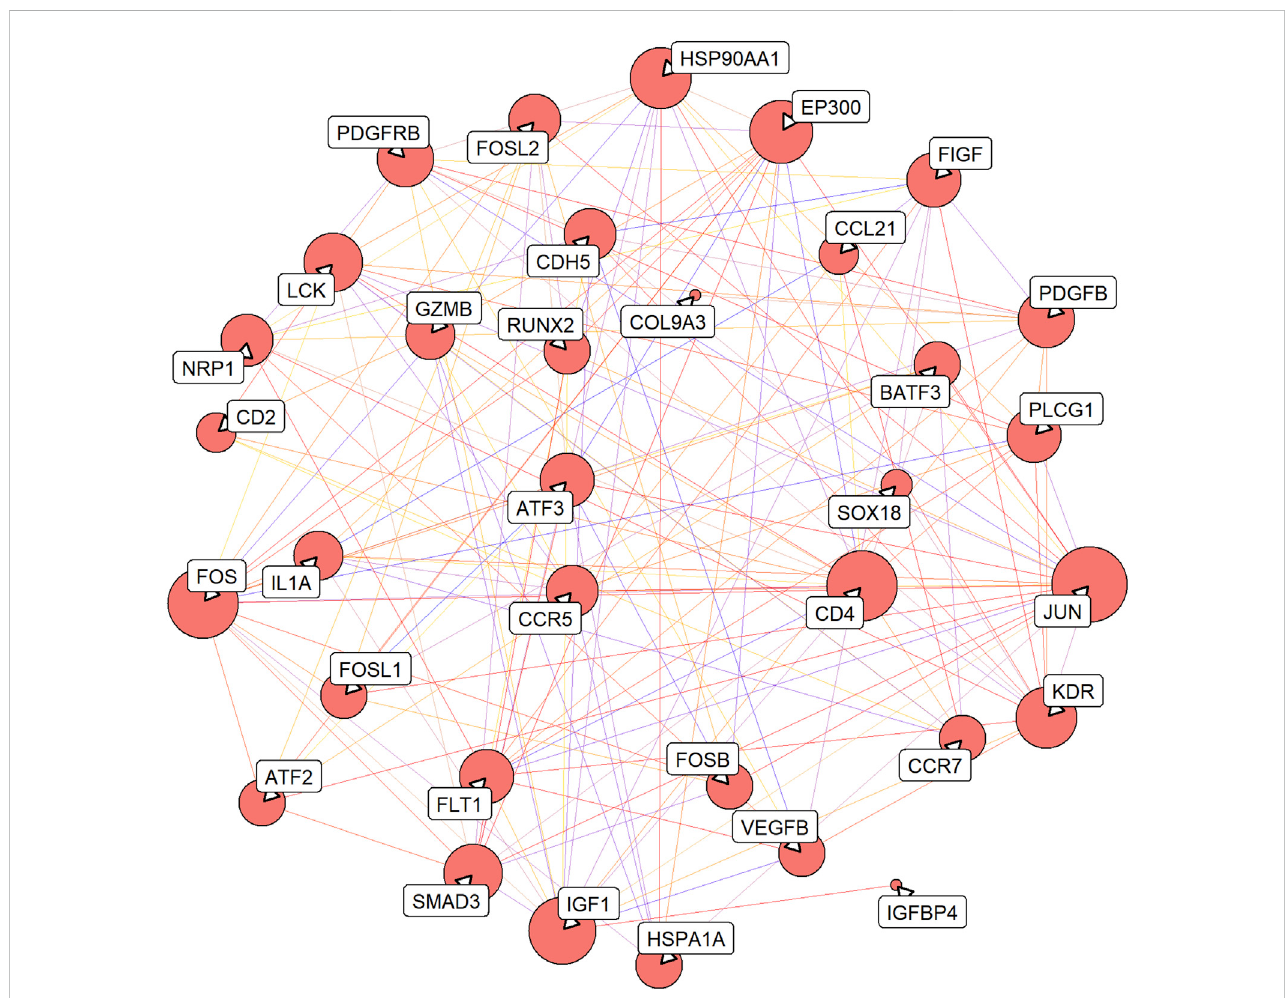
FIGURE 5 Protein-protein interaction (PPI) network of 17 key targets. The line from purple to red indicates a higher score of the reciprocal relationship, and the bigger size of the node indicates the higher degree.